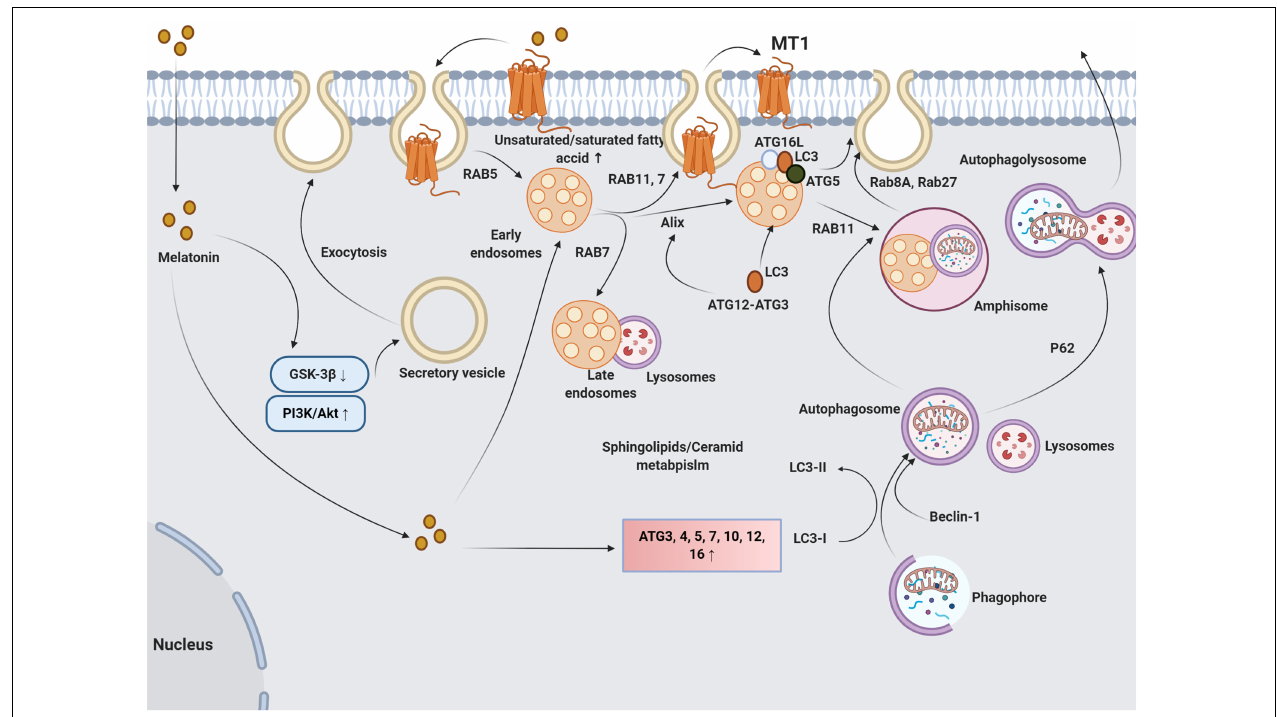
FIGURE 5 | The multiple possible means of molecular cross-talk between melatonin and exosome synthesis machinery are summarized here. Irrespective of melatonin how melatonin enters cells, it activates PI3K/Akt complex and inhibits GSK-3 β , leading to fusion of secretory vesicles with plasma membrane and exocytosis. However, the underlying mechanisms have not been fully established. Changes in plasma membrane fluidity by an alteration of fatty acid composition (unsaturated/saturate fatty acid ratio) facilitate the exosome release. Also, melatonin promotes specific GTPases including Rab7 and 11 which accelerate the fusion of late MVBs with the plasma membrane. Upon binding of melatonin to MT1, the melatonin-MT1 complex is transferred to the early endosomes via vacuolar sorting machinery such as Rab5. The activation of Rab7 and 11 promotes endosomal secretion and recycles MT1 to the plasma membrane. Further activation of Rab7 directs endosomes with MT1 toward lysosomes which regulate the innate cell response to melatonin. How Rab 7 determines the fate of endosomes with melatonin (secretion or enzymatic digestion) needs further explorations. The interplay between melatonin and autophagy signaling pathway also influences the activity of exosome molecular machinery. Melatonin stimulates autophagic response directly via the activation of ATG4, 5, 7, 10, 12, and 16 and increases the LC3II/I ratio. These features promote the formation of autophagolysosomes and autophagic exocytosis. Melatonin enhances the autophagic machinery including LC3, ATG3, 5, 12, and 16L on the late endosome membrane that facilitates the fusion of these elements with the plasma membrane. Melatonin also increases the intersection of autophagic vacuoles and exosomes into compartments named amphisomes which have multiple fates. Amphisomes can fuse with lysosomes via the activation of P62. The activity of Rab8 and 27a initiates the autophagic release of amphisomes to the ECM. GSK-3, glycogen synthase kinase 3; ATG, autophagy-related protein; P62, sequestosome 1; LC3, microtubule-associated protein 1A/1B-light chain 3; and PI3K/Akt, Phosphatidylinositol-3-kinase/Protein kinase